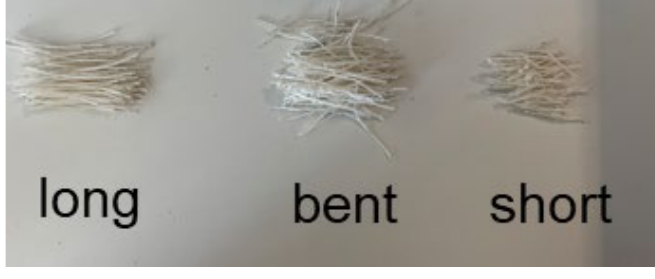
Figure 6. Shapes of RF.